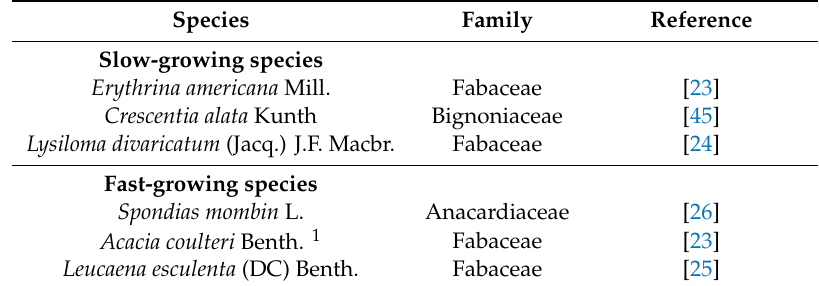
Table 1. Species and family by growth rank and references used for ranking of six species established in mixed plantings in Quilamula, Morelos, Mexico. Nomenclature follows [43] and